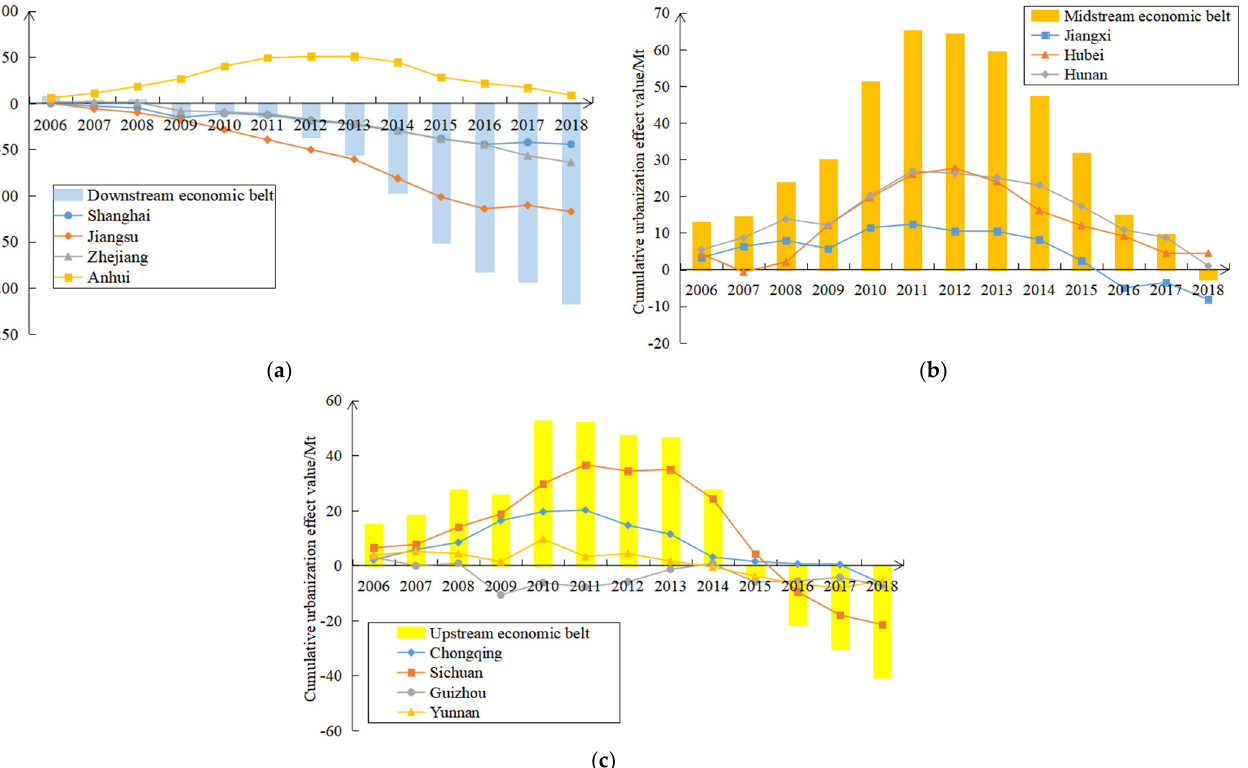
Figure 5. ( a ) Cumulative urbanization effect value of provinces and cities in the downstream eco- nomic belt; ( b ) Cumulative urbanization effect value of provinces and cities in the middle reaches of the economic belt; ( c ) Cumulative urbanization effect value of provinces and cities in the upstream economic belt [source: own illustration].